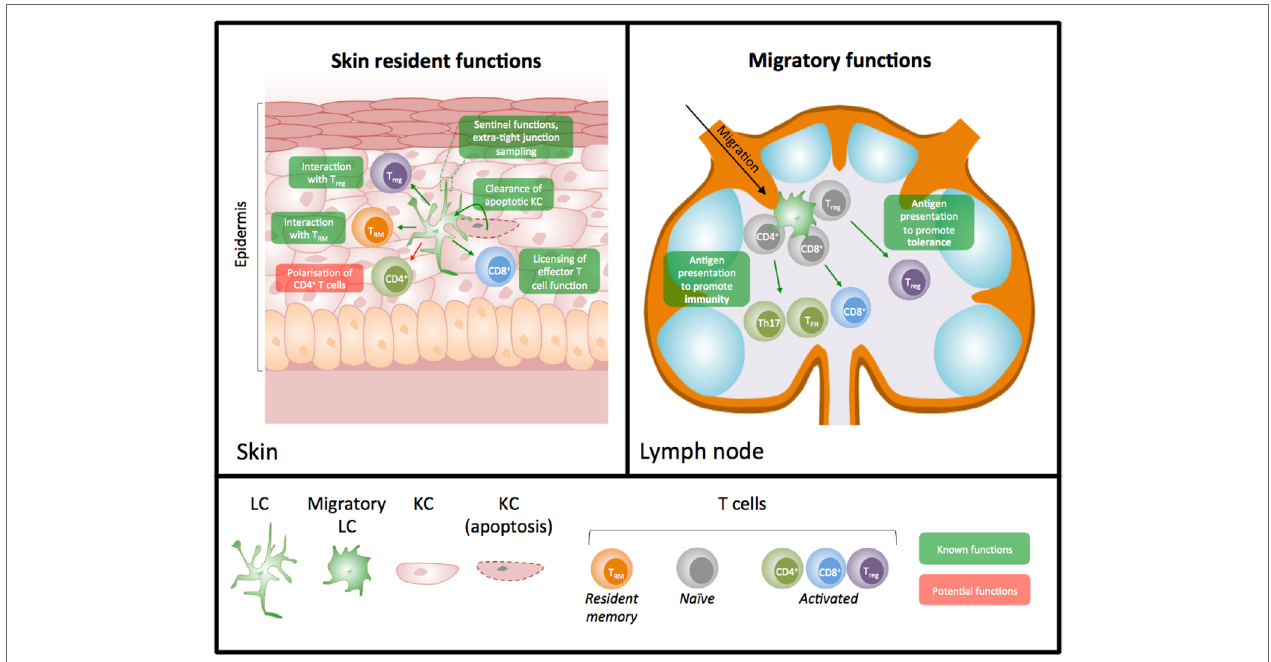
FigURe 1 | Diagram illustrating known and predicted skin resident versus migratory roles for Langerhans cells (LC). LC have important functions as resident cells in the skin and as migratory cells to the lymph nodes (LN). Studies have largely focused on their potential importance in priming T cell immunity in LN; however, it is now appreciated that LC have many functions in situ in the skin. Demonstrated functions (shown in green) in the skin include interaction with resident memory T cells, clearance of apoptotic keratinocytes, licensing of effector T cell function, sentinel functions, and interaction with regulatory T cells. Data further suggest the potential for other macrophage-like functions of LC such as a role in the polarization of CD4 + T cells in situ (shown in red).